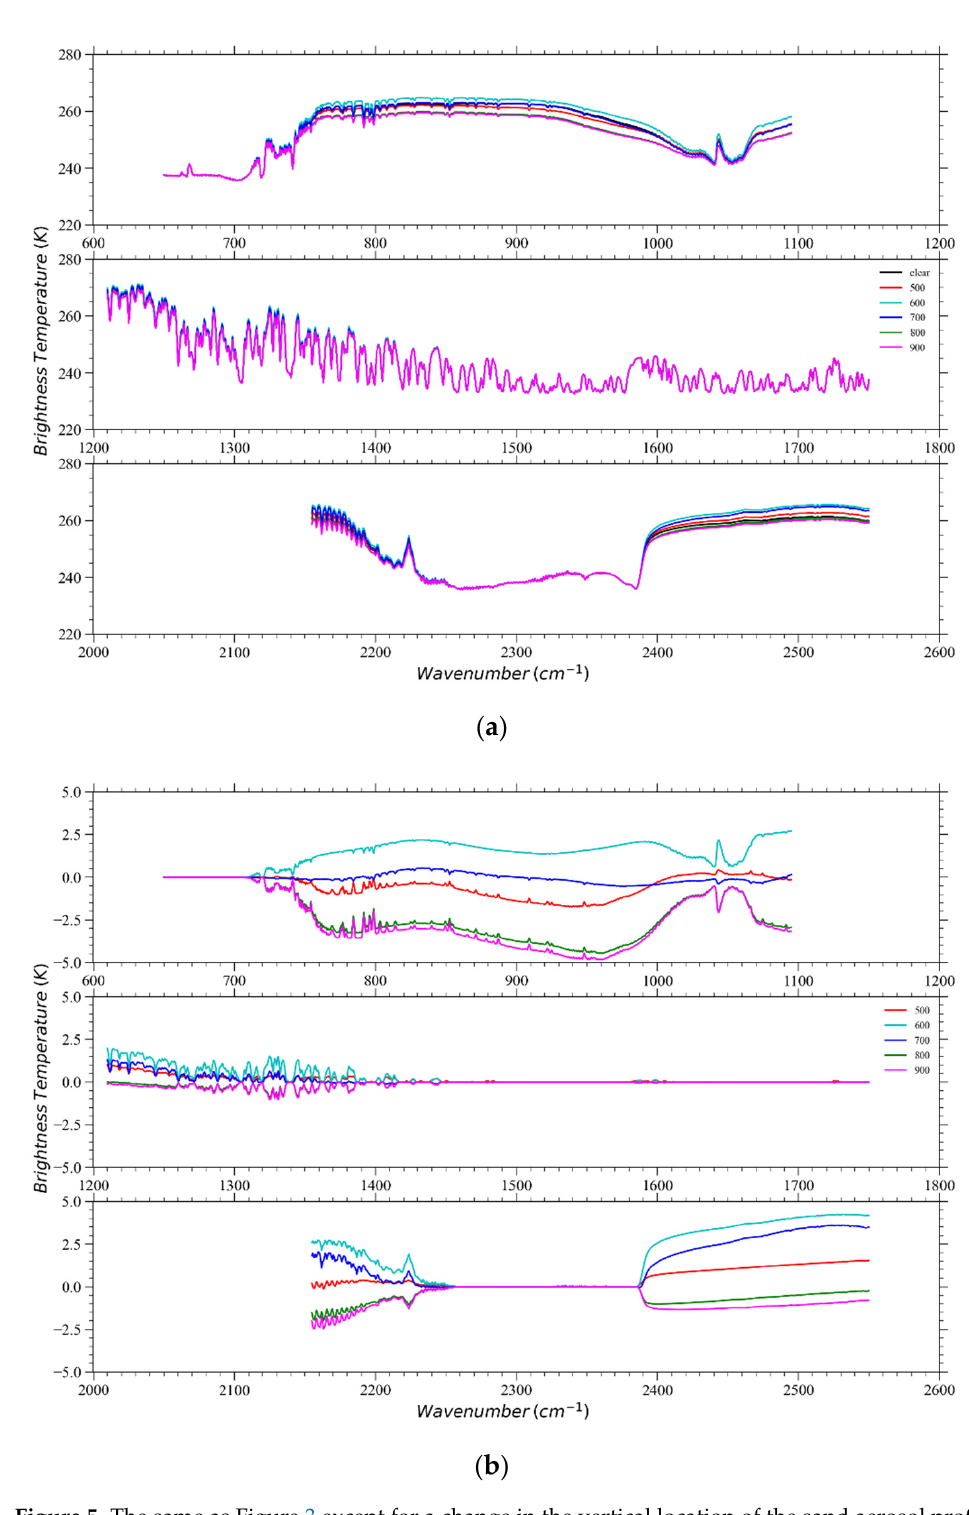
Figure 5. The same as Figure 3 except for a change in the vertical location of the sand aerosol profile. ( a ) Simulated brightness temperatures. ( b ) difference between the clear condition and different heights of the sand aerosol layers.